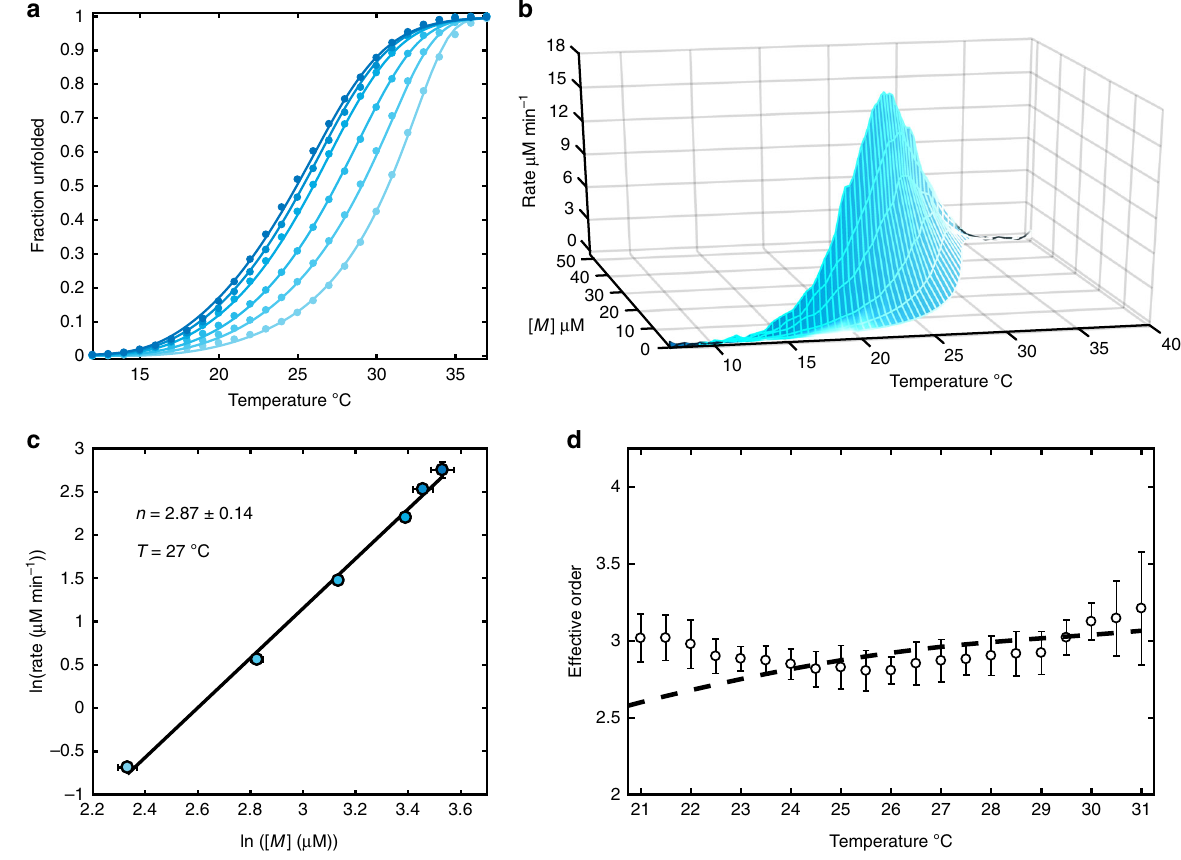
Fig. 3 Mapping the energy landscape of poly(A) fi ber assembly by TH. a Fraction unfolded TH pro fi les for poly(A) fi ber assembly as a function of temperature scan rate. Colored points are the experimental data and colored lines correspond to the globally fi t Goldstein-Stryer model for cooperative supramolecular assembly assuming a nucleus size of 3. Only every second experimental point is shown for clarity. b 3D supramolecular assembly map for poly(A) fi ber assembly. c Model-free analysis of the map in b at 27 °C. The effective assembly order n is the slope of the line. d Effective poly(A) fi ber assembly orders as a function of temperature through the annealing transition. White circles and dashed black lines are the effective orders obtained from model-free analysis of the experimental and globally fi tted data, respectively. In a – c , light to dark blue corresponds to slowest and fastest annealing scan rates respectively. In d , error bars for the experimental points were taken as the standard deviation of the values from analysis of three replicate TH